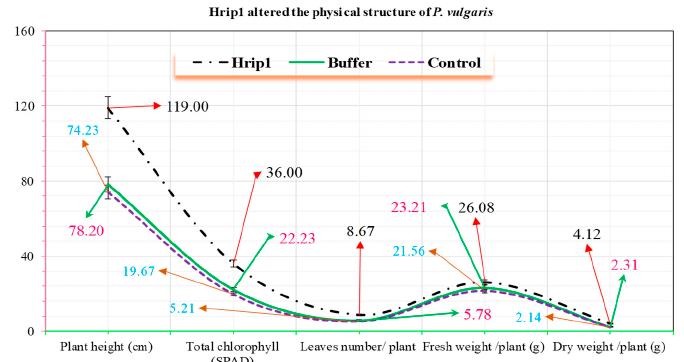
Figure 5. The effect of Hrip1 on the growth of treated and untreated seedlings ( n = 10). Hrip1 and buffer seedling (mean ± SD) data were compared by LSD and one-way ANOVA with Levene’s test ( p = 0.05) in SPSS 18.0.